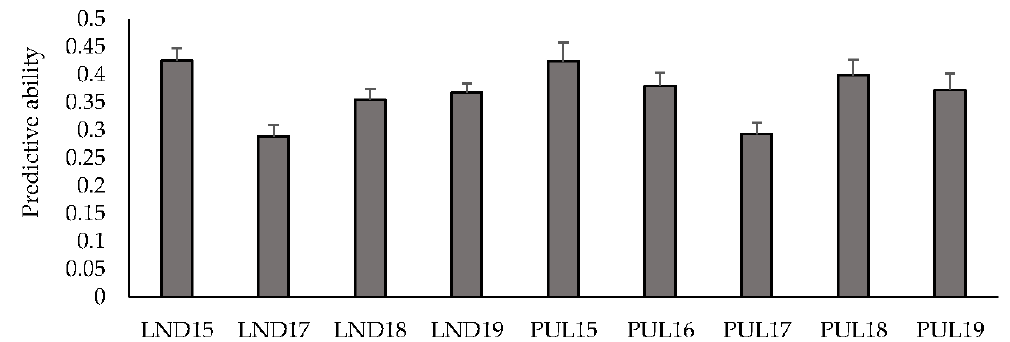
Figure 1. Predictive ability under cross-validations for grain yield across nine environments using an IBCF recommender system. Bars indicate standard errors. IBCF recommender system. Bars indicate standard